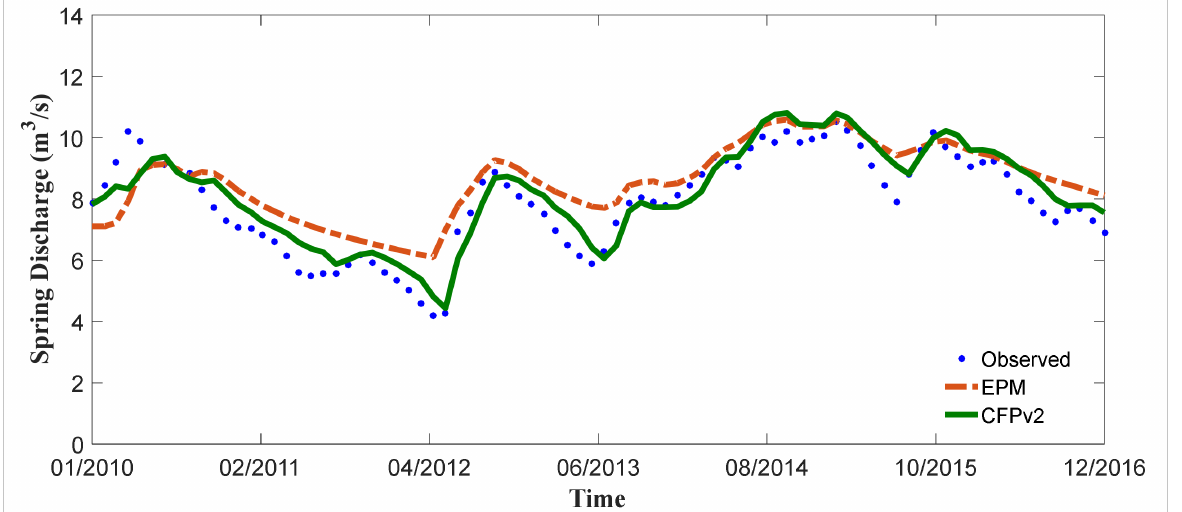
Figure 8. The observed and simulated discharge of Silver